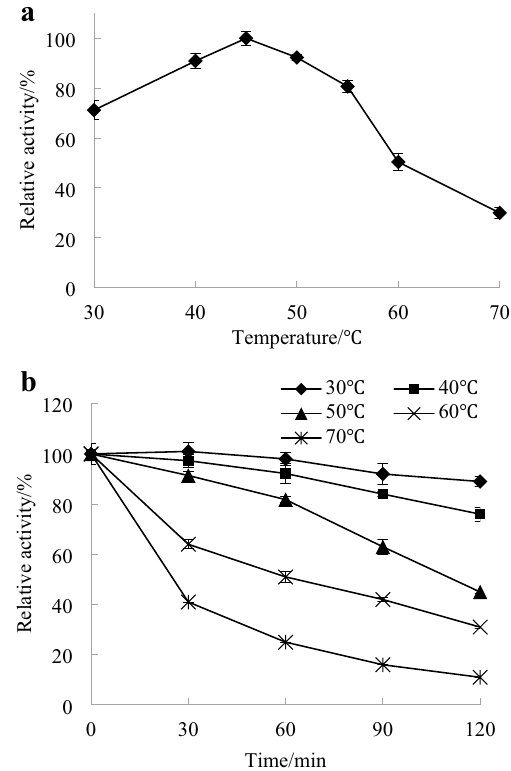
Figure 5. Effect of temperature on the activity ( a ) and stability ( b ) of